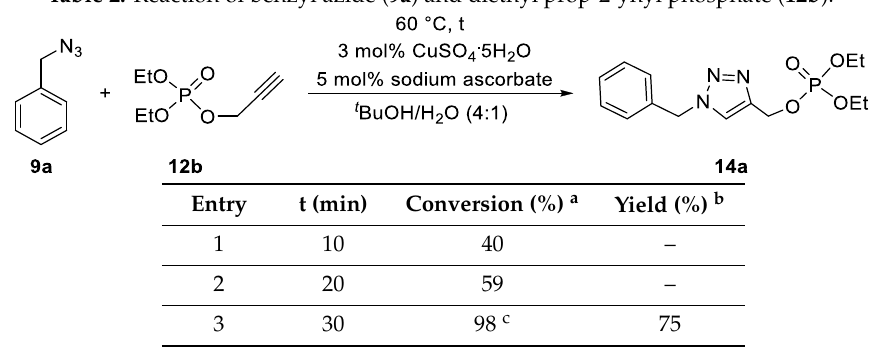
Table 2. Reaction of benzyl azide ( 9a ) and diethyl prop-2-ynyl phosphate ( 12b ).